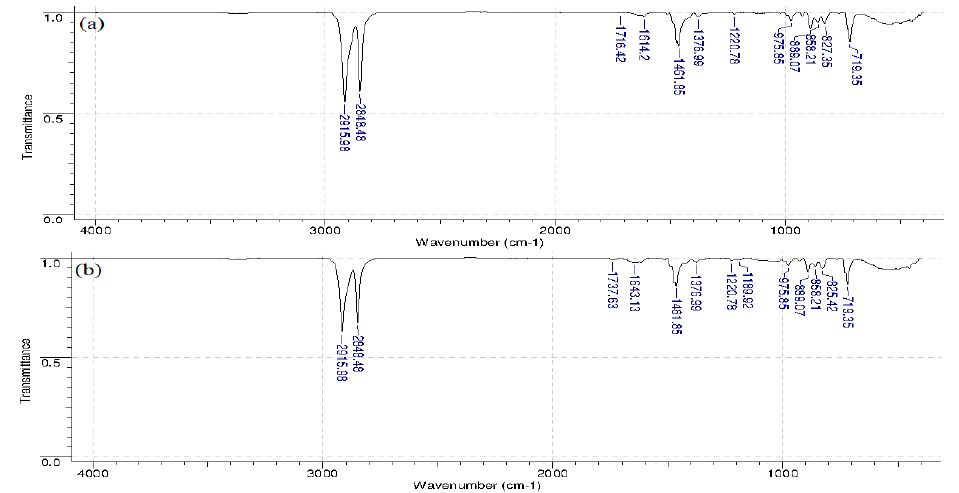
Figure 10. IR spectra of the Ralex AMH anion-exchange membrane before use in the electrodialyzer ( a ) and after use in the electrodialyzer ( b ).